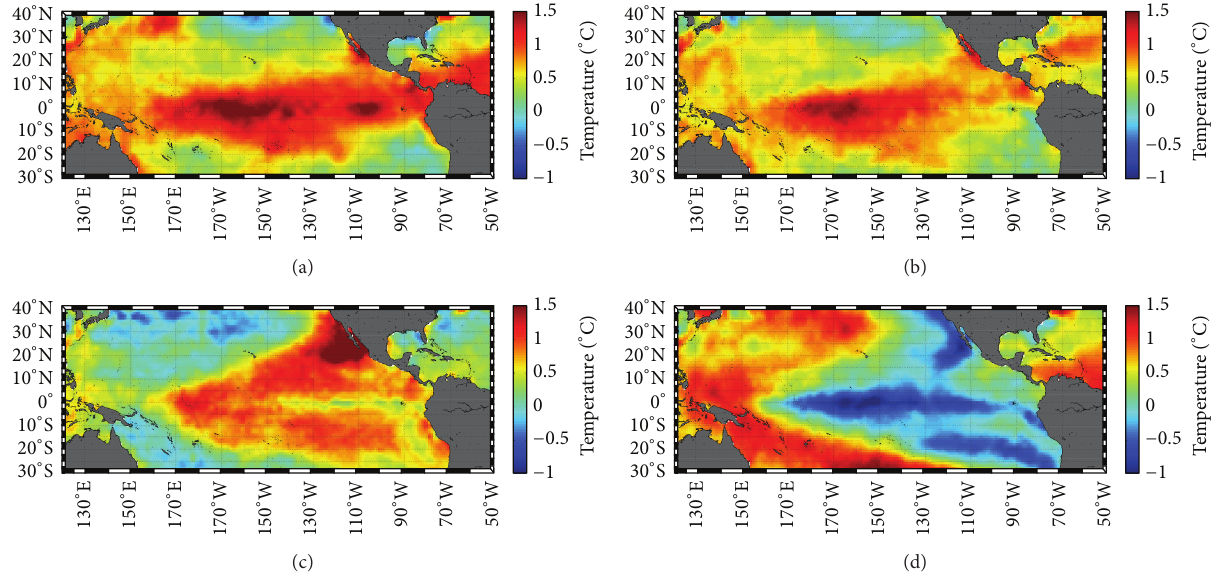
Figure 1: SST anomaly of (a) 2009-2010, (b) 2002-2003, (c) 1992-1993, and (d) 2010-2011 as examples for El Ni˜no, El Ni˜no Modoki I, El Ni˜no Modoki II, and La Ni˜na events, respectively.